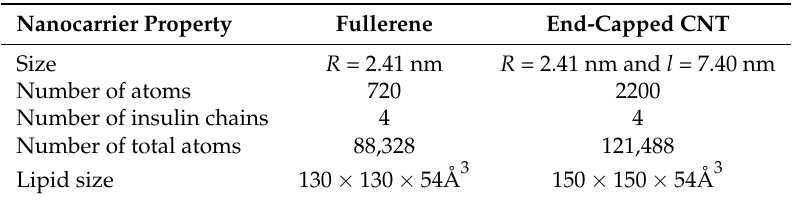
Table 1. Properties of two types of